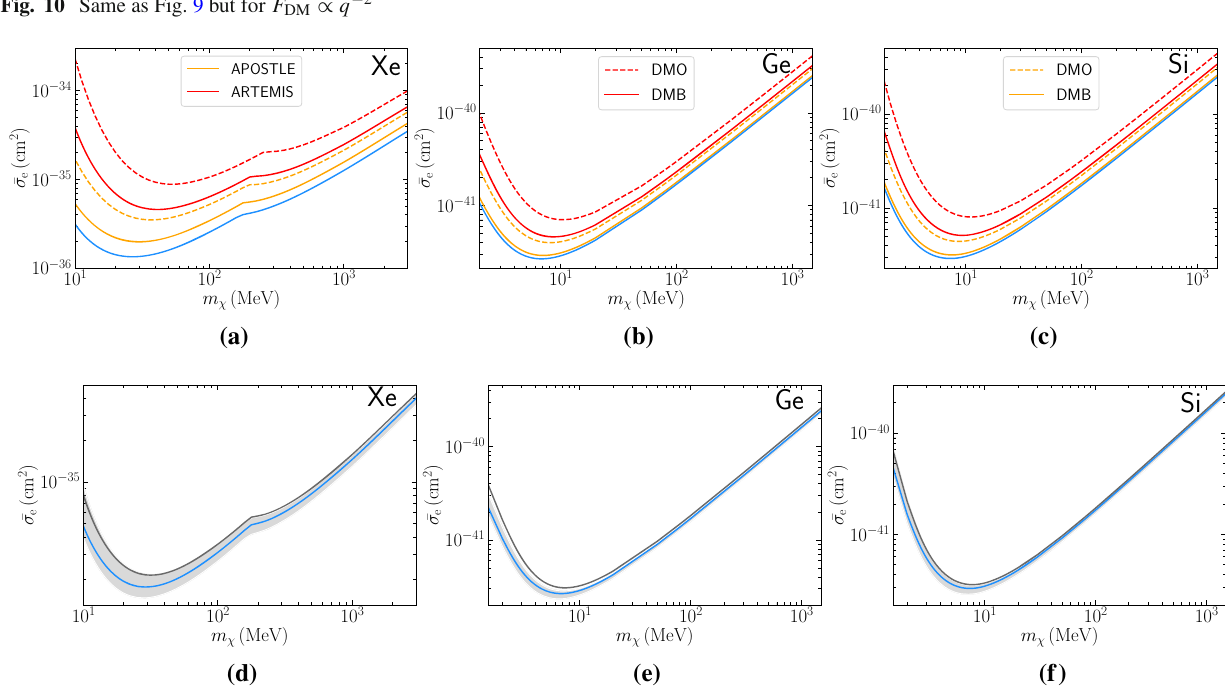
Fig. 11 Shifts in the exclusion limitsfor DPL distribution with F DM ∝ q − 1 . In the upper panel we show the variations for the best fit values of different cosmological simulations. The bands in the lower panel repre-